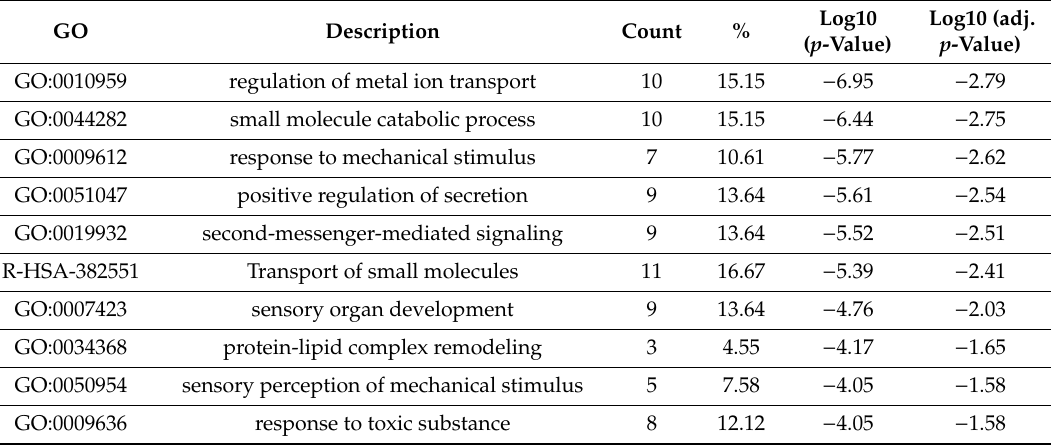
Table 1. Top 10 enriched terms among the astrocyte-specific DEGs.